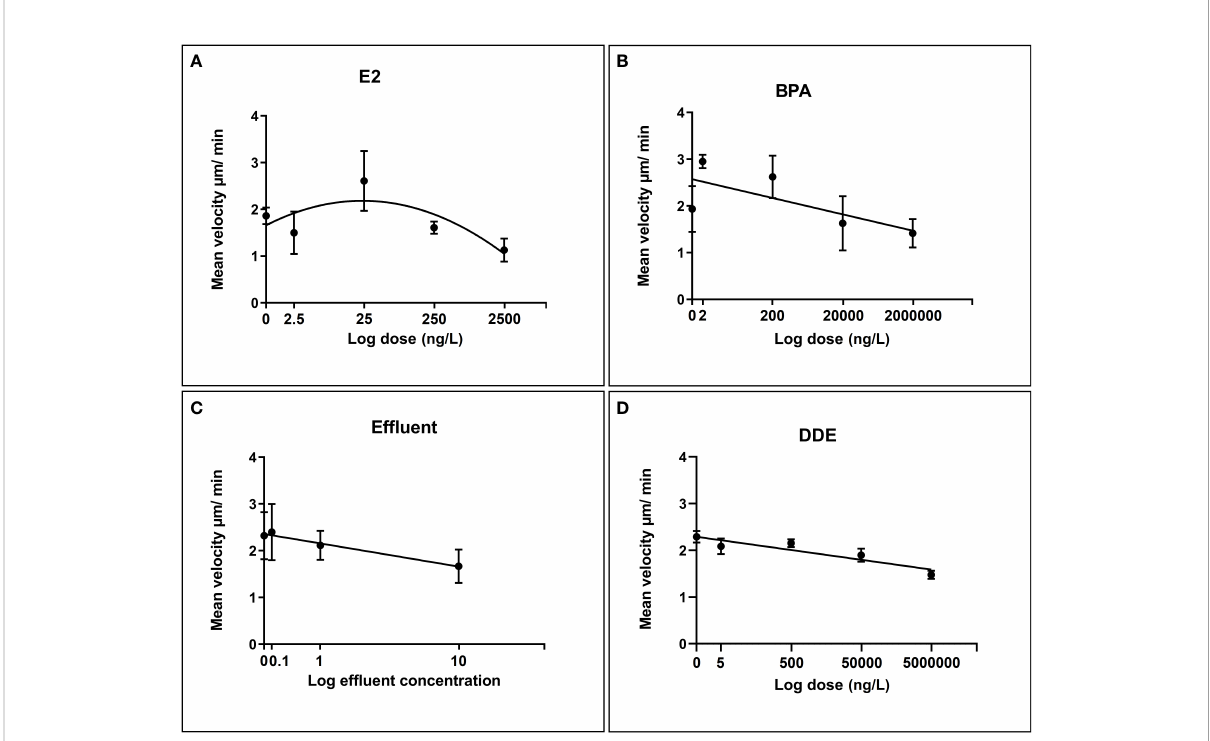
FIGURE 5 Regression relationships between log dose of test chemicals against B glabrata hemocyte motility in vitro . Data points for hemocyte motility plotted as mean velocity (µm/min) ± SEM of three independent replicates. (A) Hemocyte motility response to E2 exposure (B) Hemocyte motility response to BPA exposure (C) Hemocyte motility response to Ef fl uent exposure (D) Hemocyte motility response to p,p ’ -DDE